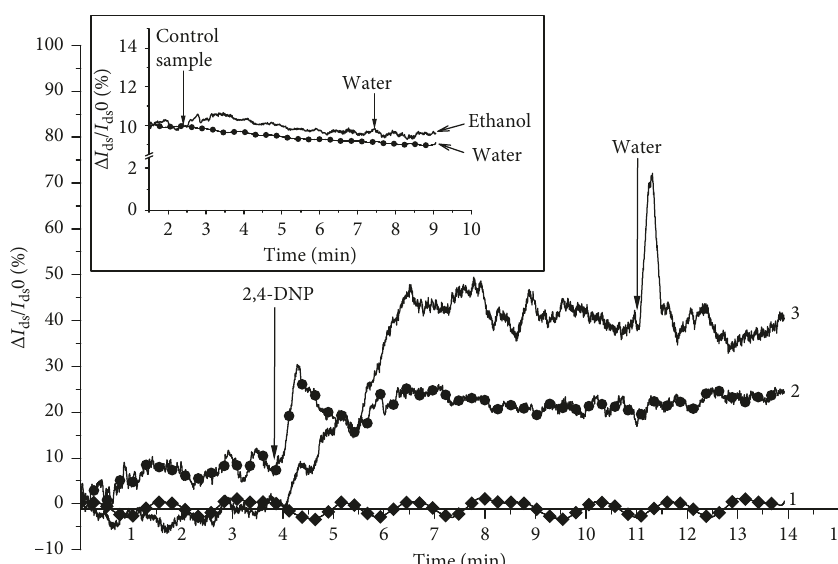
Figure 3: Time dependencies of the normalized differential signal from the SOI-NW sensor obtained upon DNP detection. DNP concentration 3 × 10 − 15 M (curve 1), 3 × 10 − 14 M (curve 2), and 3 × 10 − 13 M (curve 3) in deionized water. Inset displays examples of curves obtained in control experiments upon the addition of DNP-free solutions (ethanol or water) into the measuring cell. Experimental conditions: V g � 20V, V ds � 0.2V, and total solution volume in the cell 450 μ L. Arrows indicate addition of DNP solution and washing with